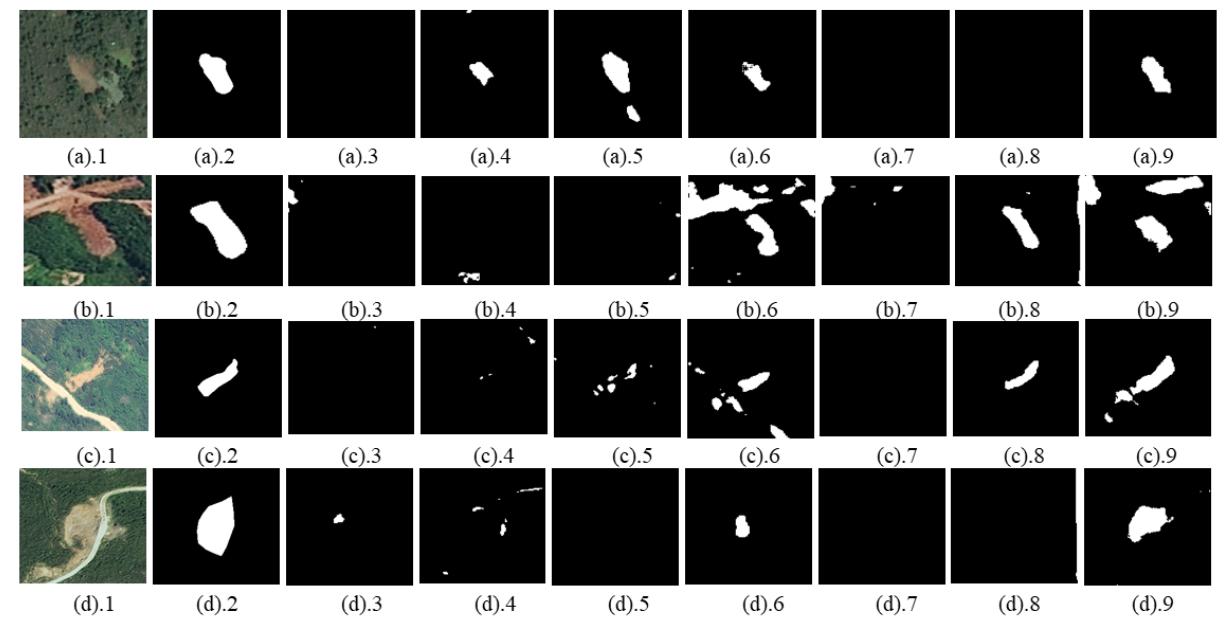
Figure 9. Visual comparison of landslide detection on images of the Bijie landside dataset between our proposed DeenNet and the other networks: (*).1 indicate patches of the original image, (*).2 represent ground-truth image patches, (*).3–(*).8 are the results of U-net, U-net + residual module, SegNet, SegNet + residual module, Deeplabv3, and Deeplabv3+ residual module, respectively; (*).9 represent images detected by our DeenNet.